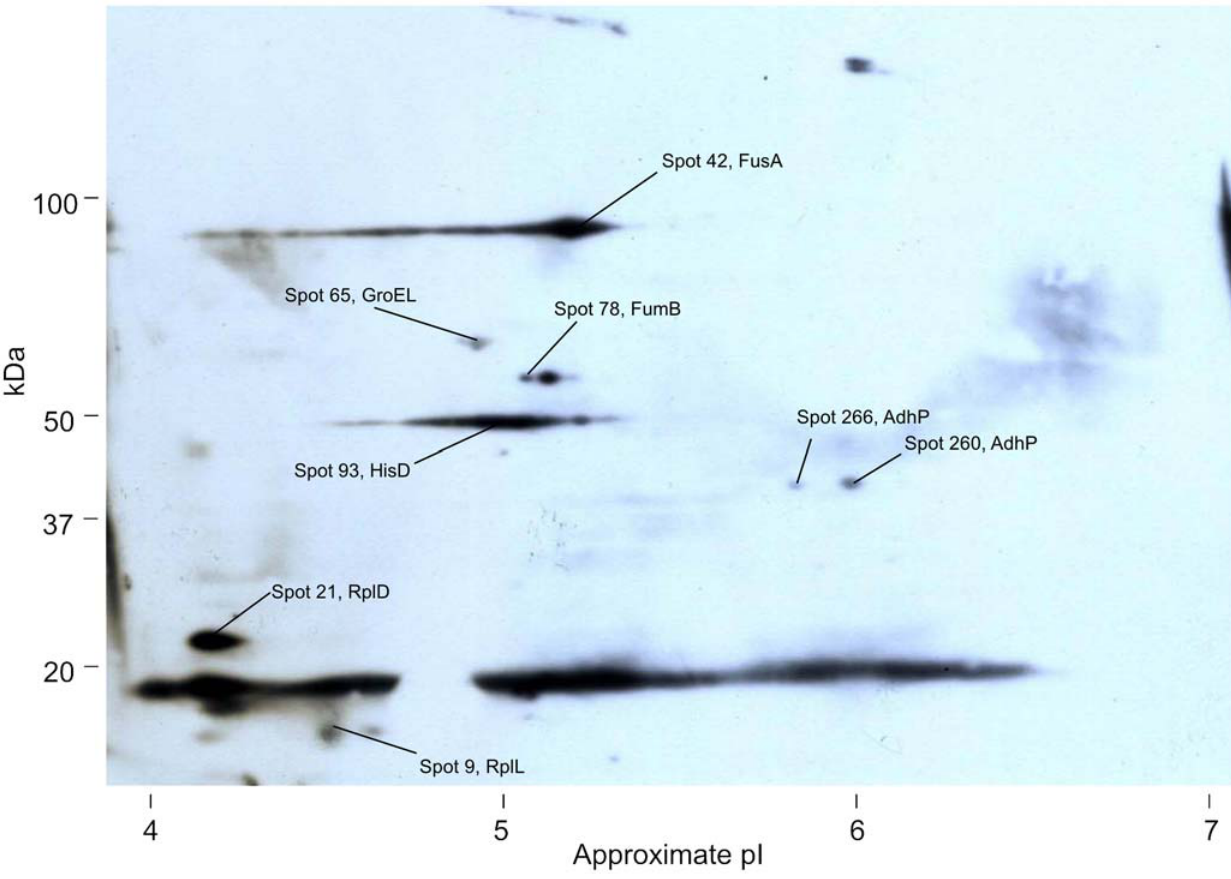
Figure 2. An example western blot of a 2D gel of total protein. Total N. meningitidis proteins separated by 2D gel electrophoresis using a non- linear pI 4–7 1 st dimension, western blotted, and probed with convalescent sera from patient 3. Spots that were assigned protein identities are indicated. Spots with no protein legend have not been identified. Longer exposures of this blot revealed more spots (Table 2).